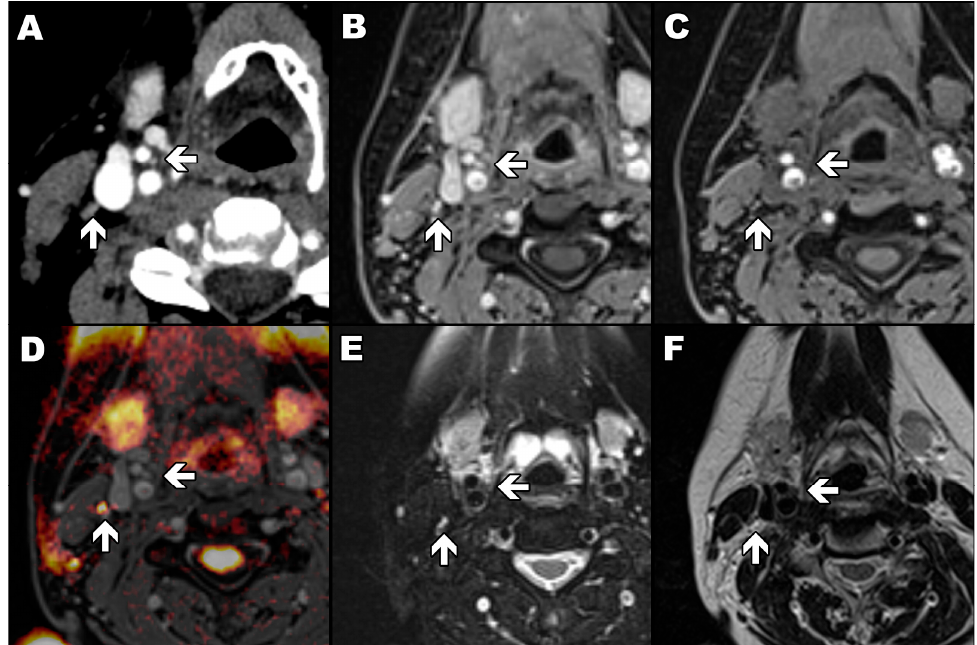
Figure 1. Signal characteristics of the carotid body and lymphatic node. Arrows mark the carotid body ( ← ) and lymph node ( ↑ ). Axial contrast-enhanced computed tomography image of the patient with marked carotid body and lymph node ( A ); VIBE sequence in T1-weighted image with Dixon technique in the water-only image with ( B ) and without ( C ) contrast agent enhancement; diffusion- weighted image with b value of 1000 s/mm 2 automatically fused with contrasted-enhanced VIBE sequence in T1-weighted image with Dixon technique in the water-only image ( D ); turbo spin-echo sequence in T2-weighted image with ( E ) and without ( F ) fat saturation.